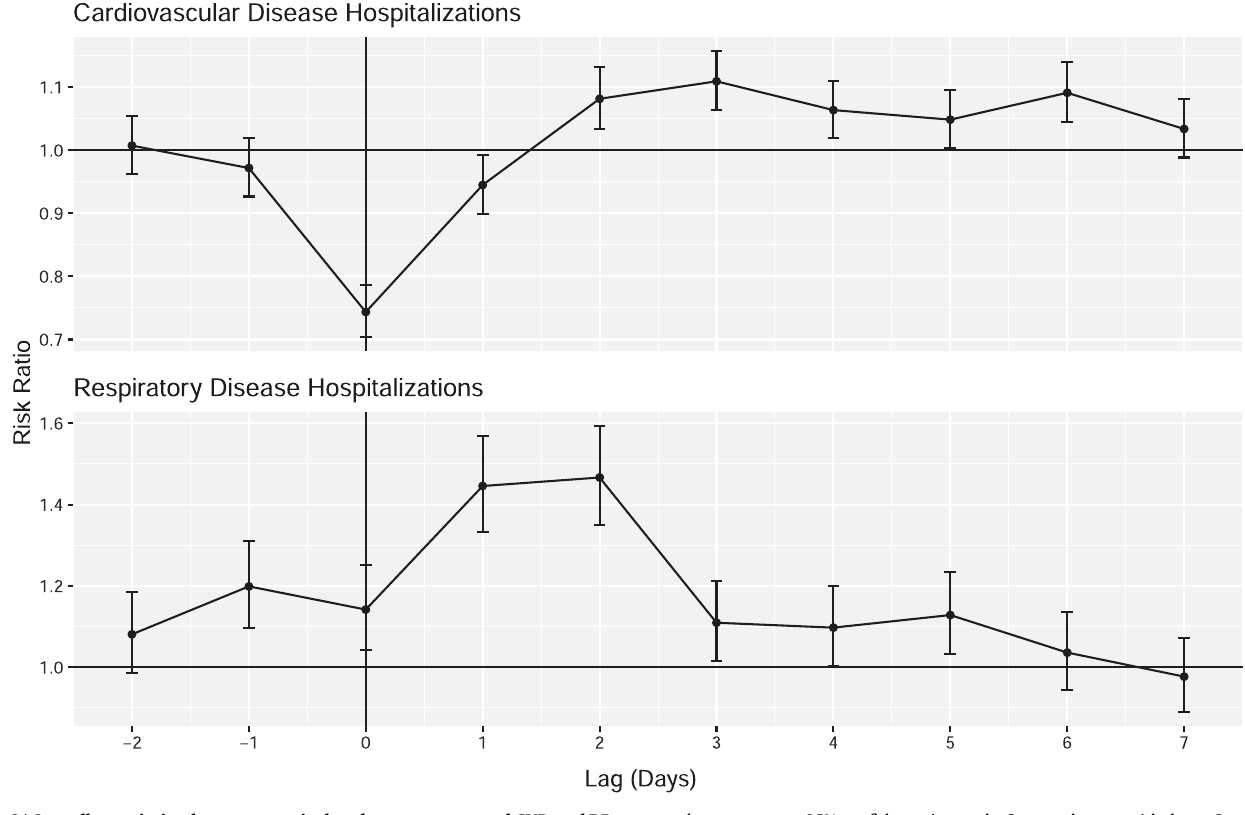
error bars represent 95% con fi dence intervals. Source data provided as a Source Data fi